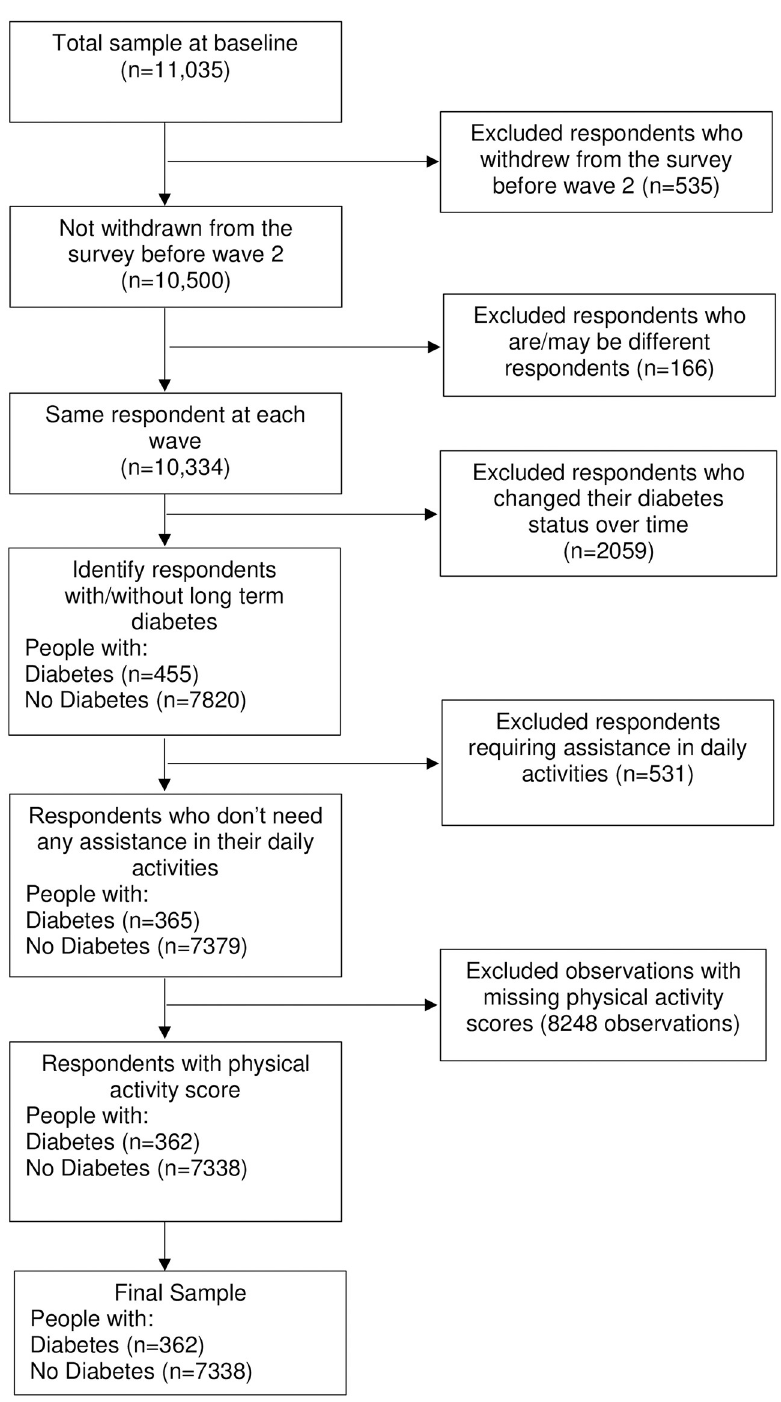
Fig 1. Process Chart for the